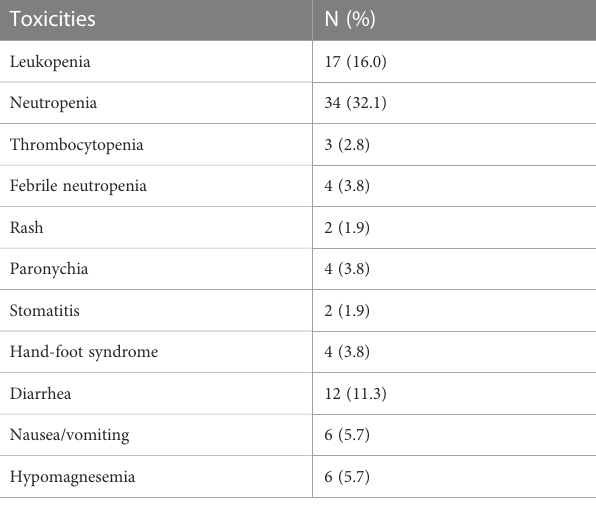
TABLE 5 Grade 3-4 treatment toxicities, Hong Kong, 2019 – 2021 (N = 106).